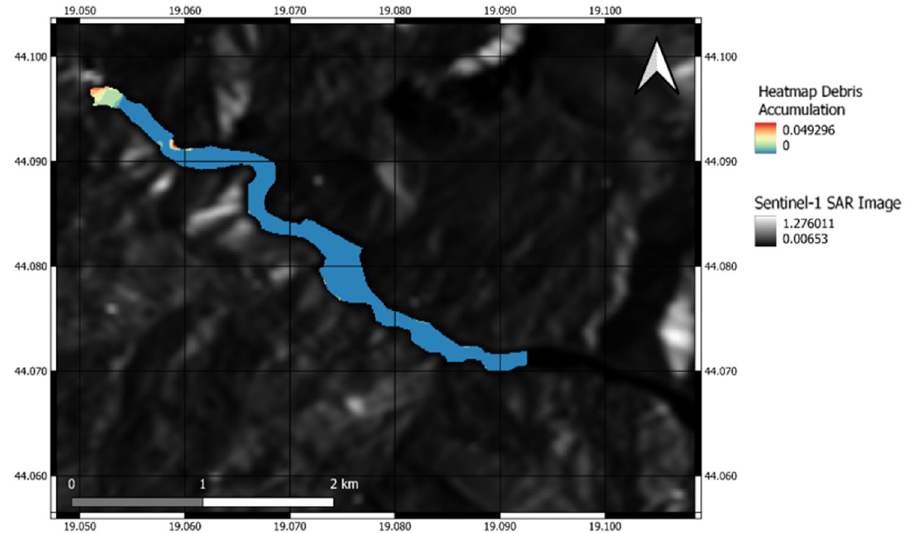
Figure 15. Heatmap of Drina River system and hydroelectric dam near Visegrad from 5 January 2019 to 26 December 2021 (total 142 acquisitions) (Sentinel-1, Credits: ESA).